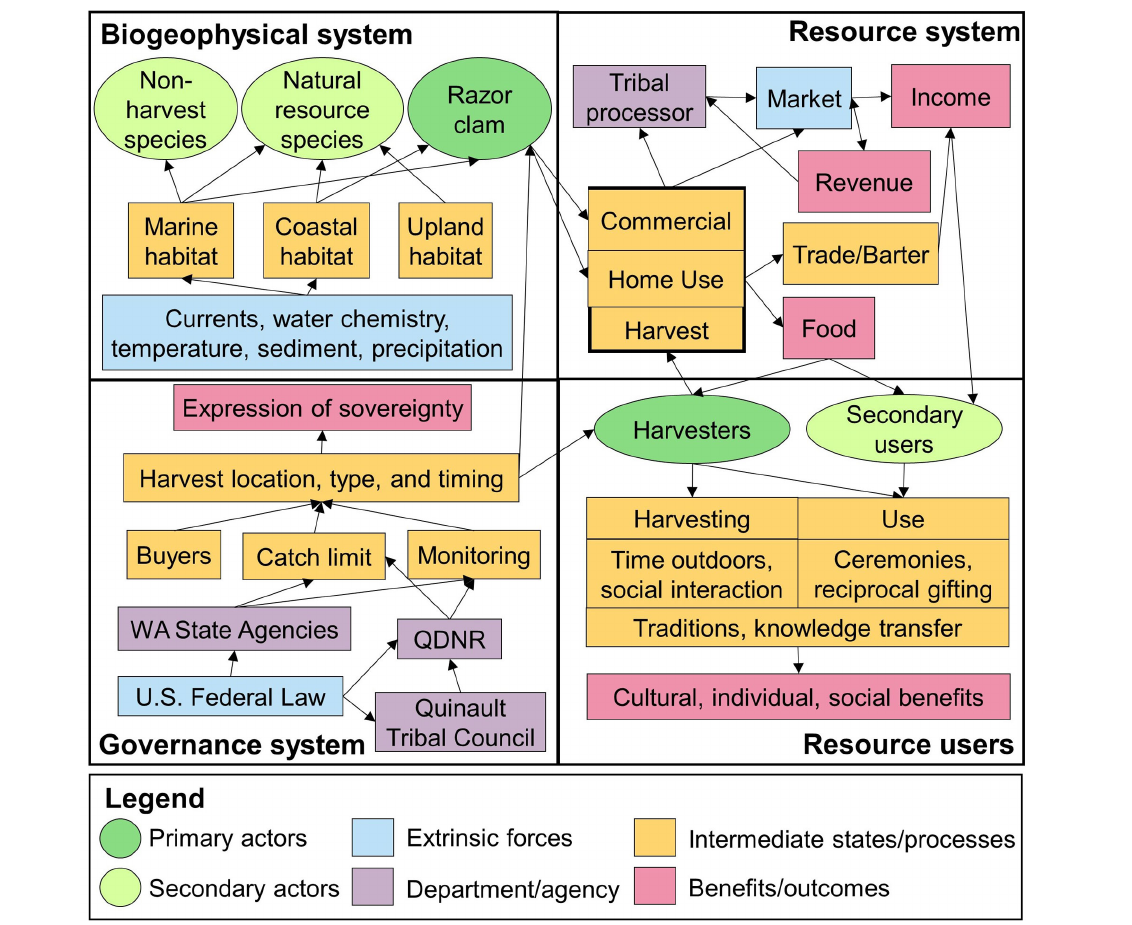
Fig. 2 . Compressed version of the social-ecological system (SES) conceptual model, structured according to Ostrom’s (2009) SES framework and based on interview data (full conceptual model in Appendix 2).QNDR stands for the Quinault Department of Natural